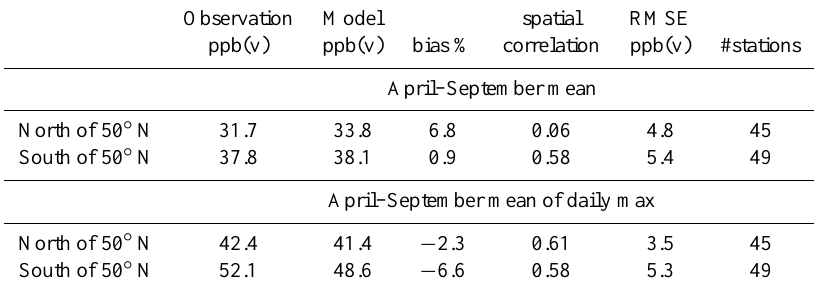
Table 1. Modelled surface O 3 compared to observed values over the years 1990–2009 at EBAS stations in Europe a .